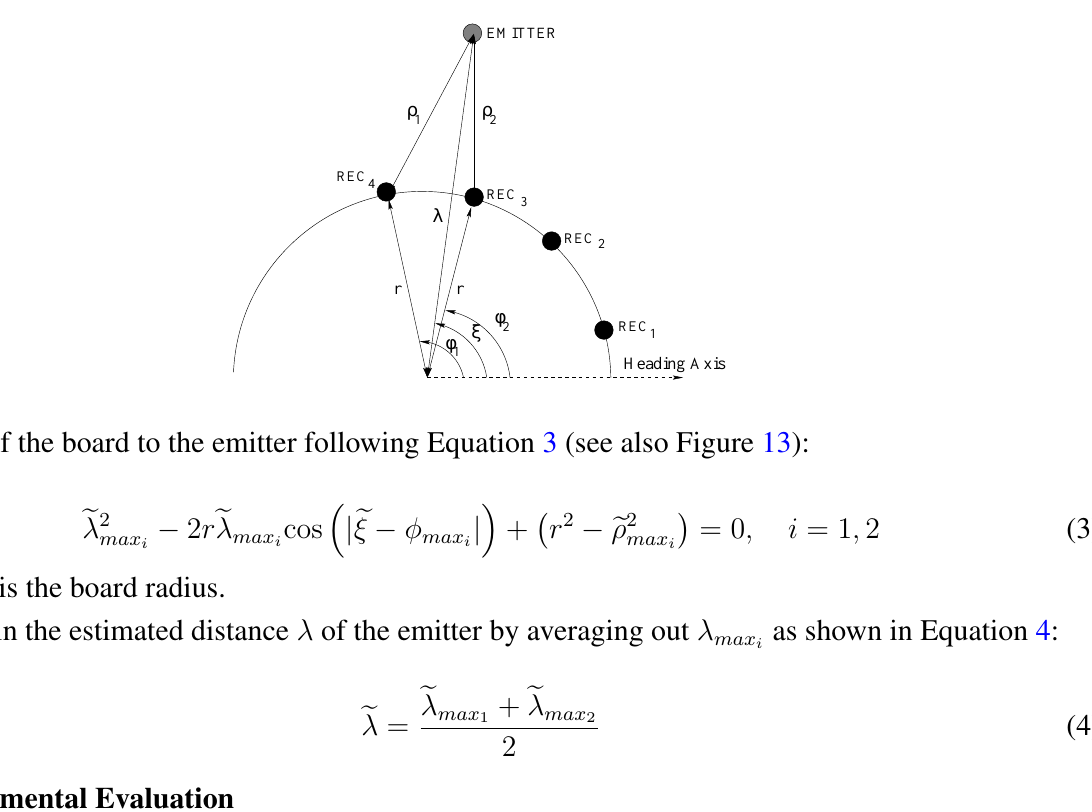
Figure 13. Reception diagram for a specific location and its distance to the different